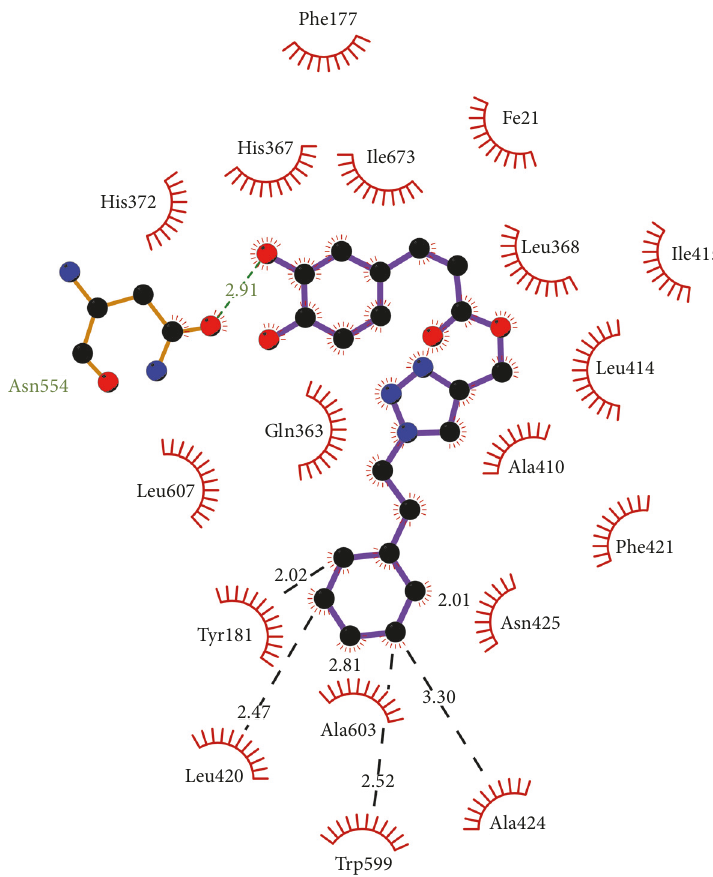
Figure 7: Molecular docking results of 12g displayed in